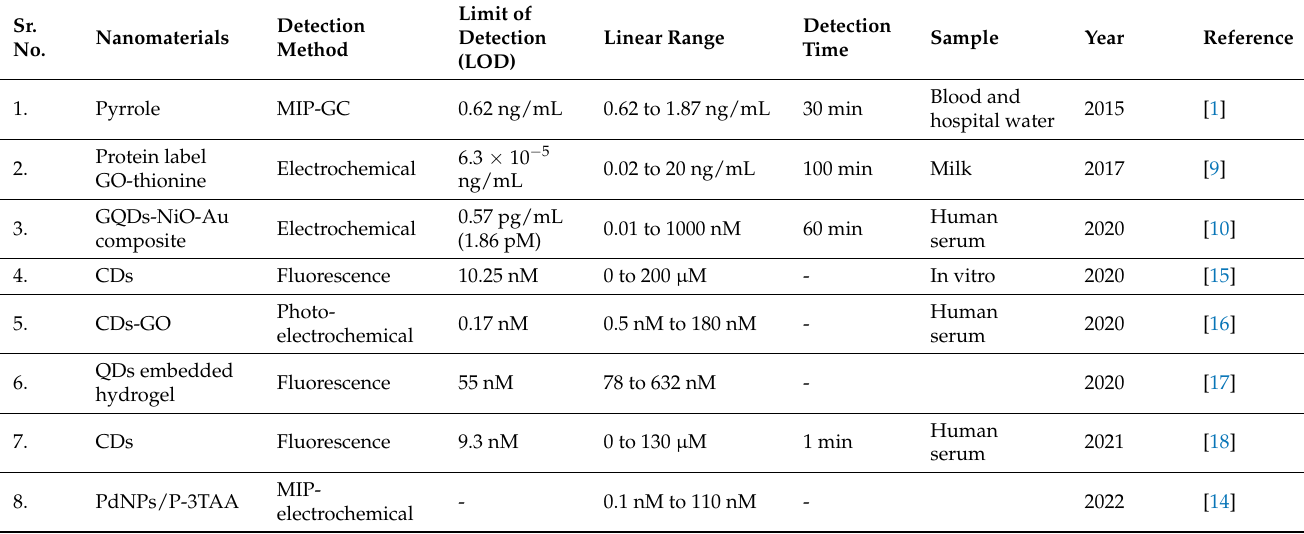
Table 1. The summarised reported literature on sensing progesterone hormone in biological as well as environmental